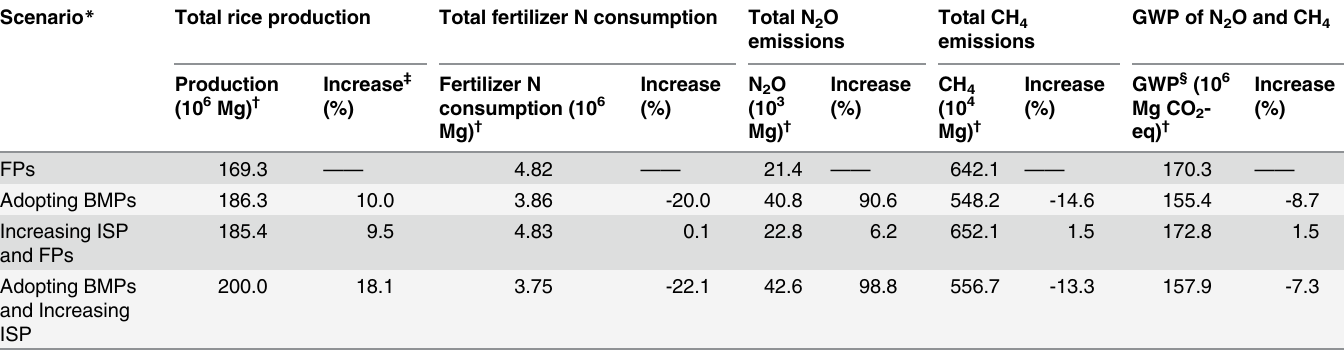
Table 2. Total rice production, N fertilizer consumption and greenhouse gas emissions (N 2 O, CH 4 and GWP) across Chinese major rice farming systems following different